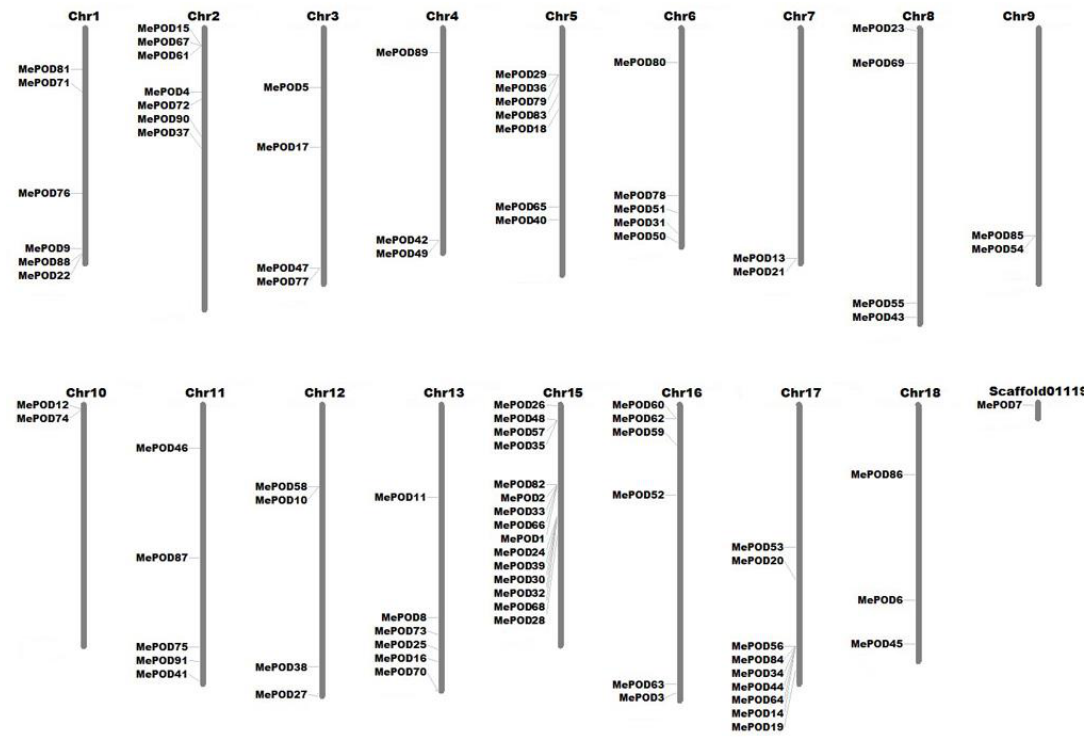
Figure 4. Chromosome distribution analyses of POD gene subgroups in cassava. The chromosomal information of 91 MePODs was collected from the Phytozome 12.0 cassava database, and the genes were then mapped to 17 chromosomes and one scaffold. MapInspect software (Wageningen University, Wageningen, Netherlands) was used to draw this figure.